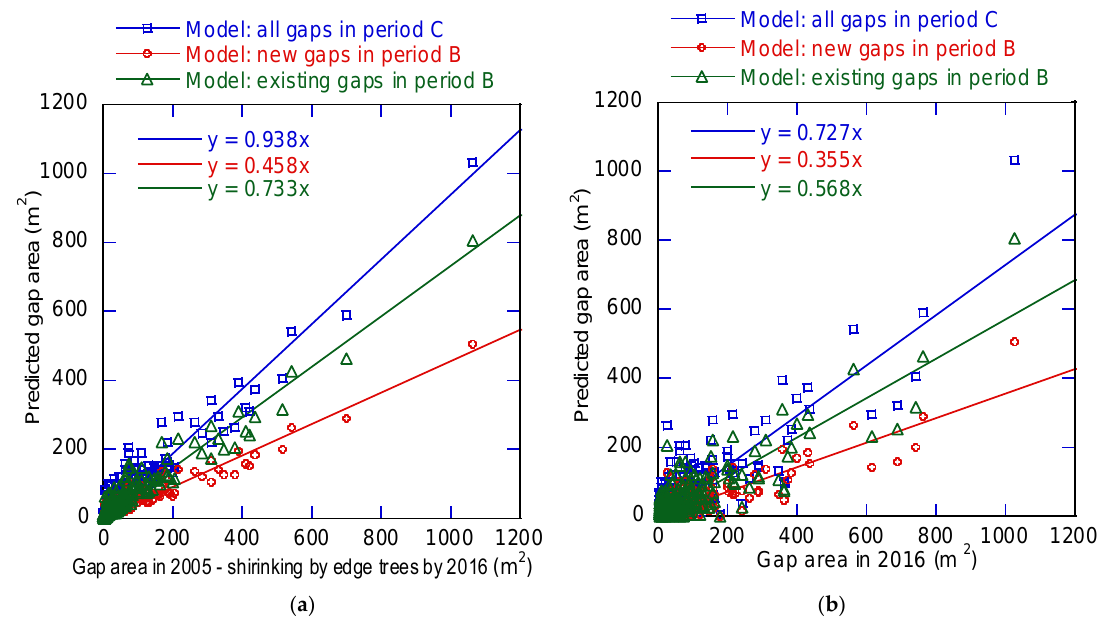
Figure 10. Gap area prediction. ( a ) Predicted gap area after shrinkage by lateral growth of edge trees; ( b ) predicted gap area after shrinkage by lateral growth of edge trees and understory vegetation growth, and expansion. From model (10) for 11 years of period C, we obtained a model predicting the dura- tion N (years) until gap closure (gap lifespan).